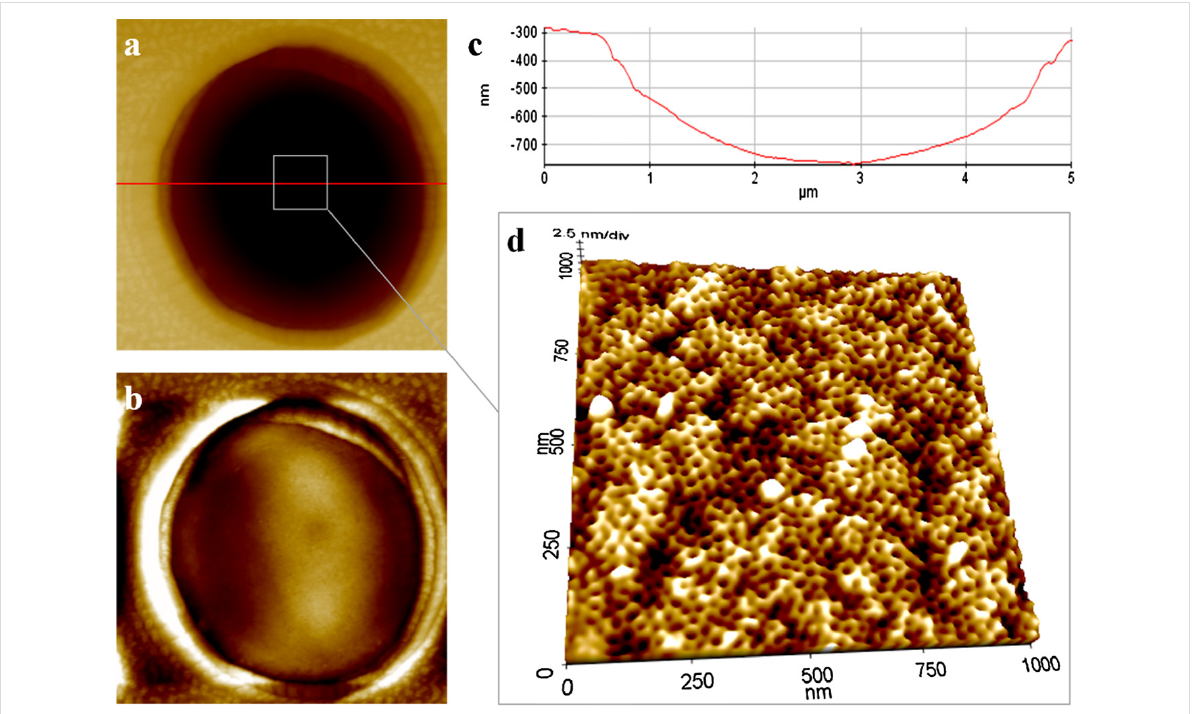
Figure 4: a) Atomic force microscopy (AFM) images of a composite nanoporous membrane: detail of the Si microsieve with the nanoporous poly- meric membrane on top. b) Corrected AFM image showing the coverage of the Si macropore by the polymeric membrane. c) AFM profile correspond- ing to the horizontal line in a). d) 3D AFM image showing the morphology of the nanoporous layer within the macropore. Reprinted with permission from [64], copyright 2014